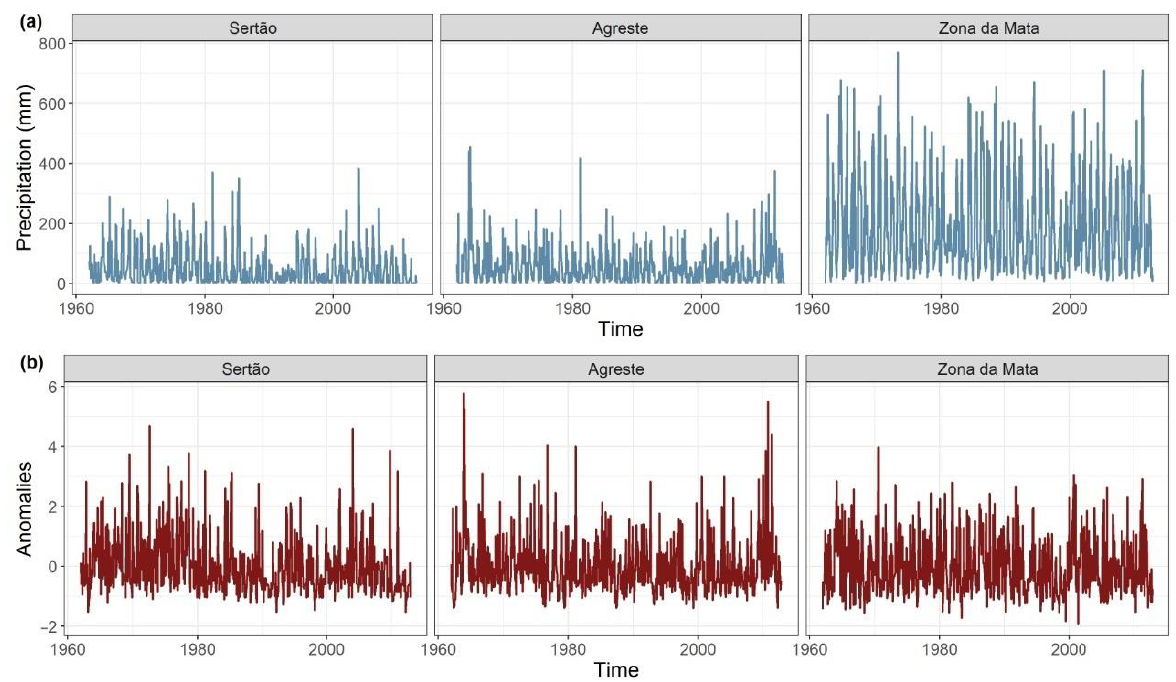
Figure 2. The original monthly rainfall series ( a ) and monthly anomalies ( b ) for three representative stations (red circles on the map in Figure 1).